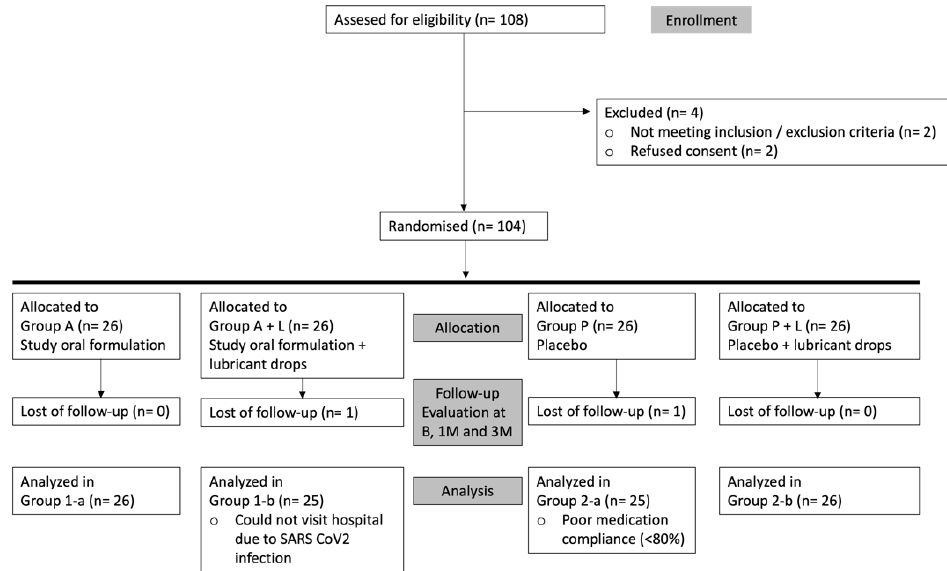
Figure 3. Efficacy Study. Flow chart for enrolment, allocation, evaluation, and analysis (B = baseline, 1M = 1 month, 3M = 3 months).